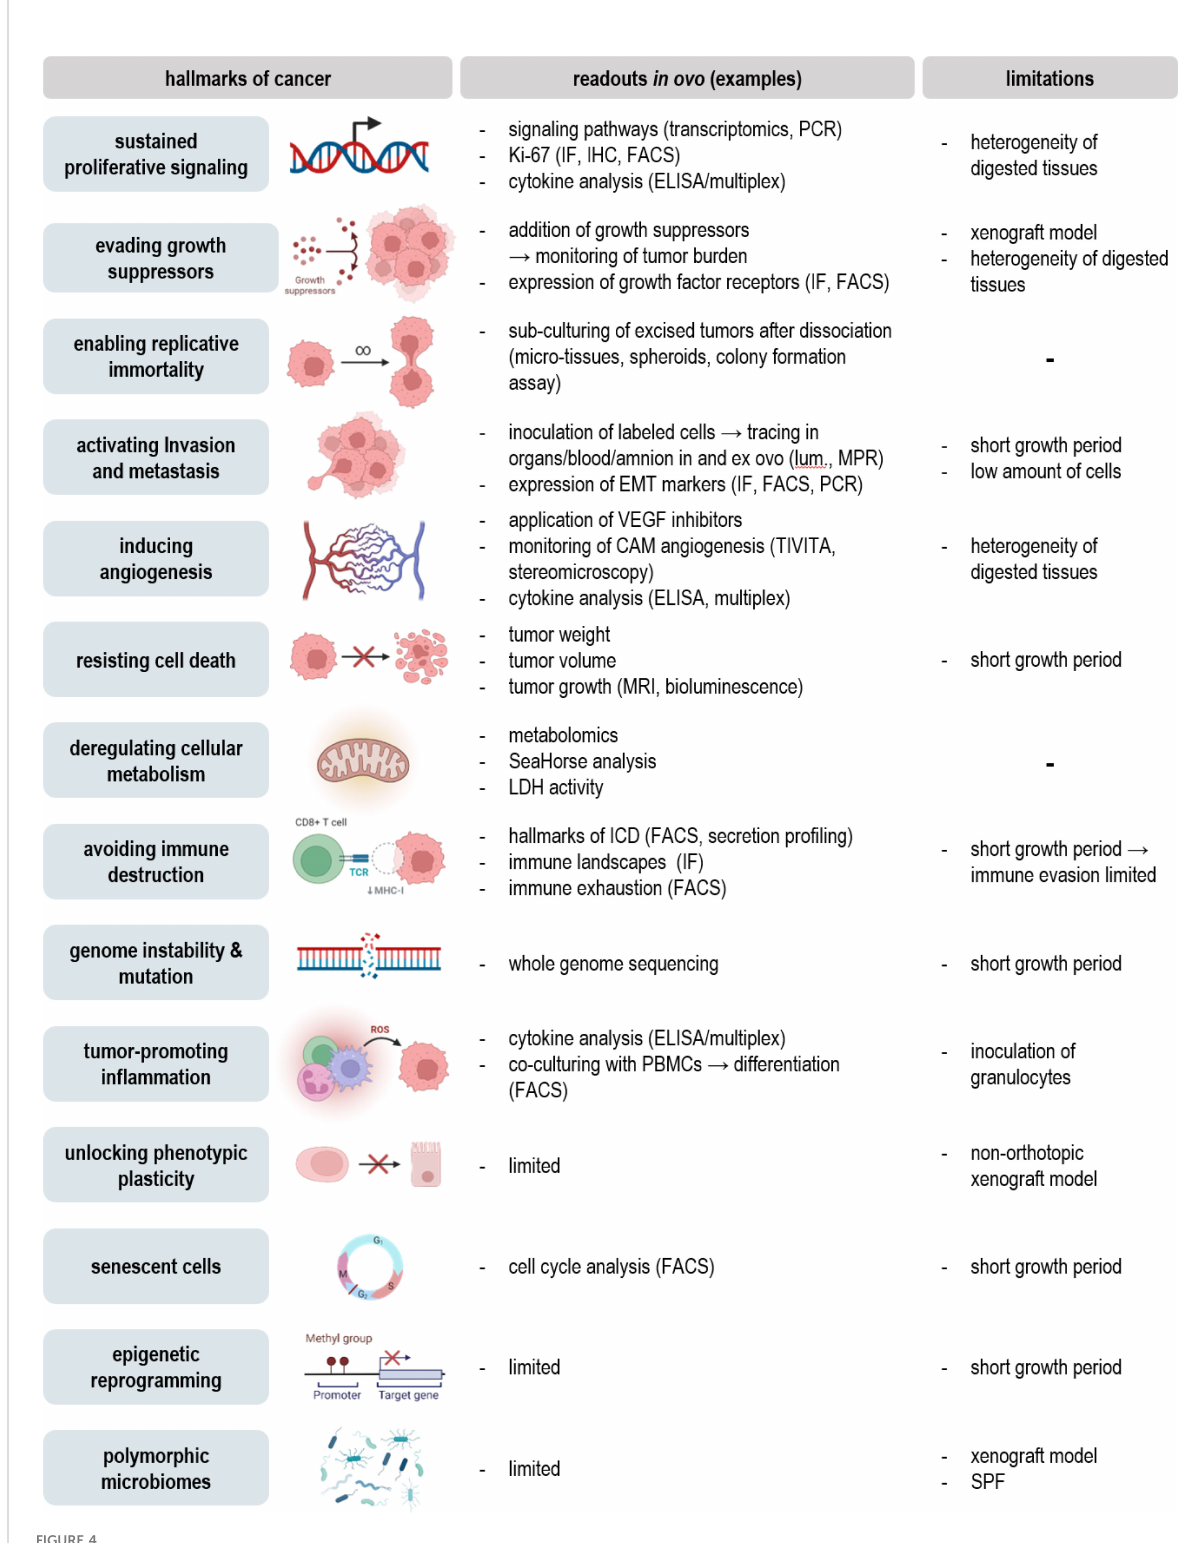
FIGURE 4 Addressing the hallmarks of cancer in ovo